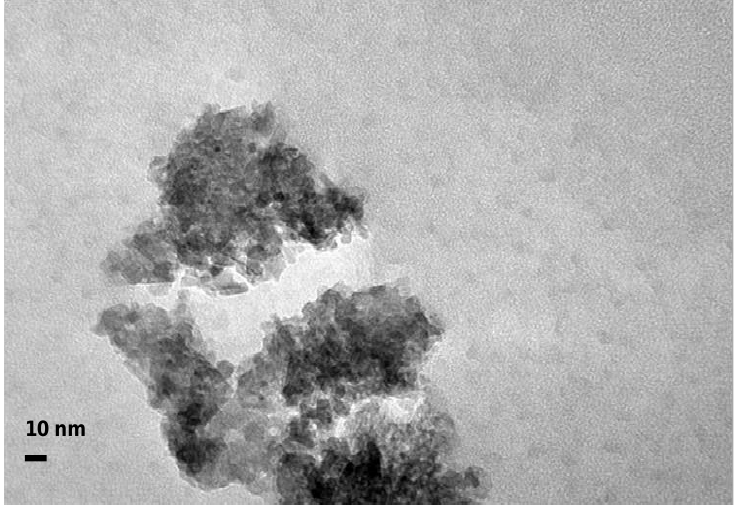
Figure A6. Microphotography of Ru/Al 2 O 3 -K(10 wt%) catalyst.